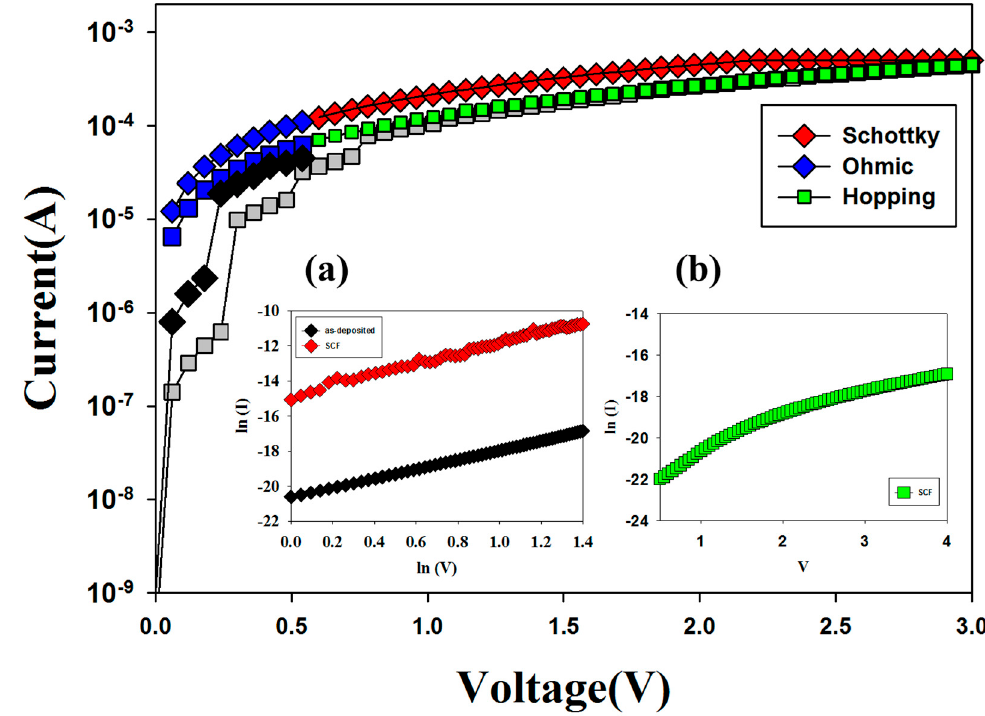
Figure 6. The electrical conduction mechanism of the SCF-treated and non-treated neodymium oxide thin films for ( a ) ohmic conduction and ( b ) hopping conduction mechanism.